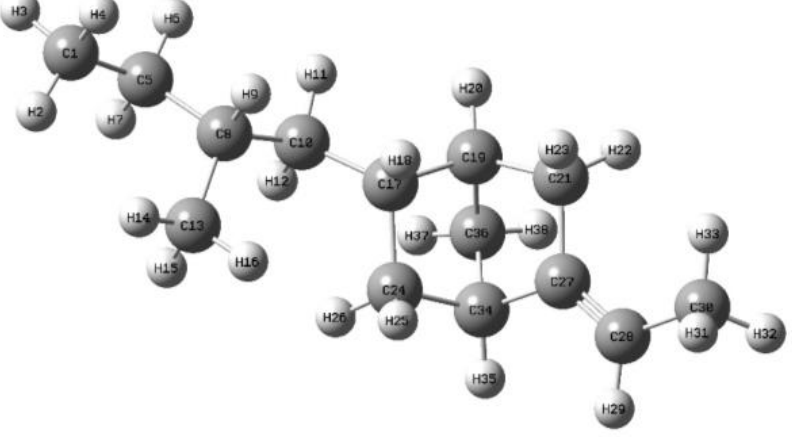
Figure 2. Monomeric molecular model of EPDM.